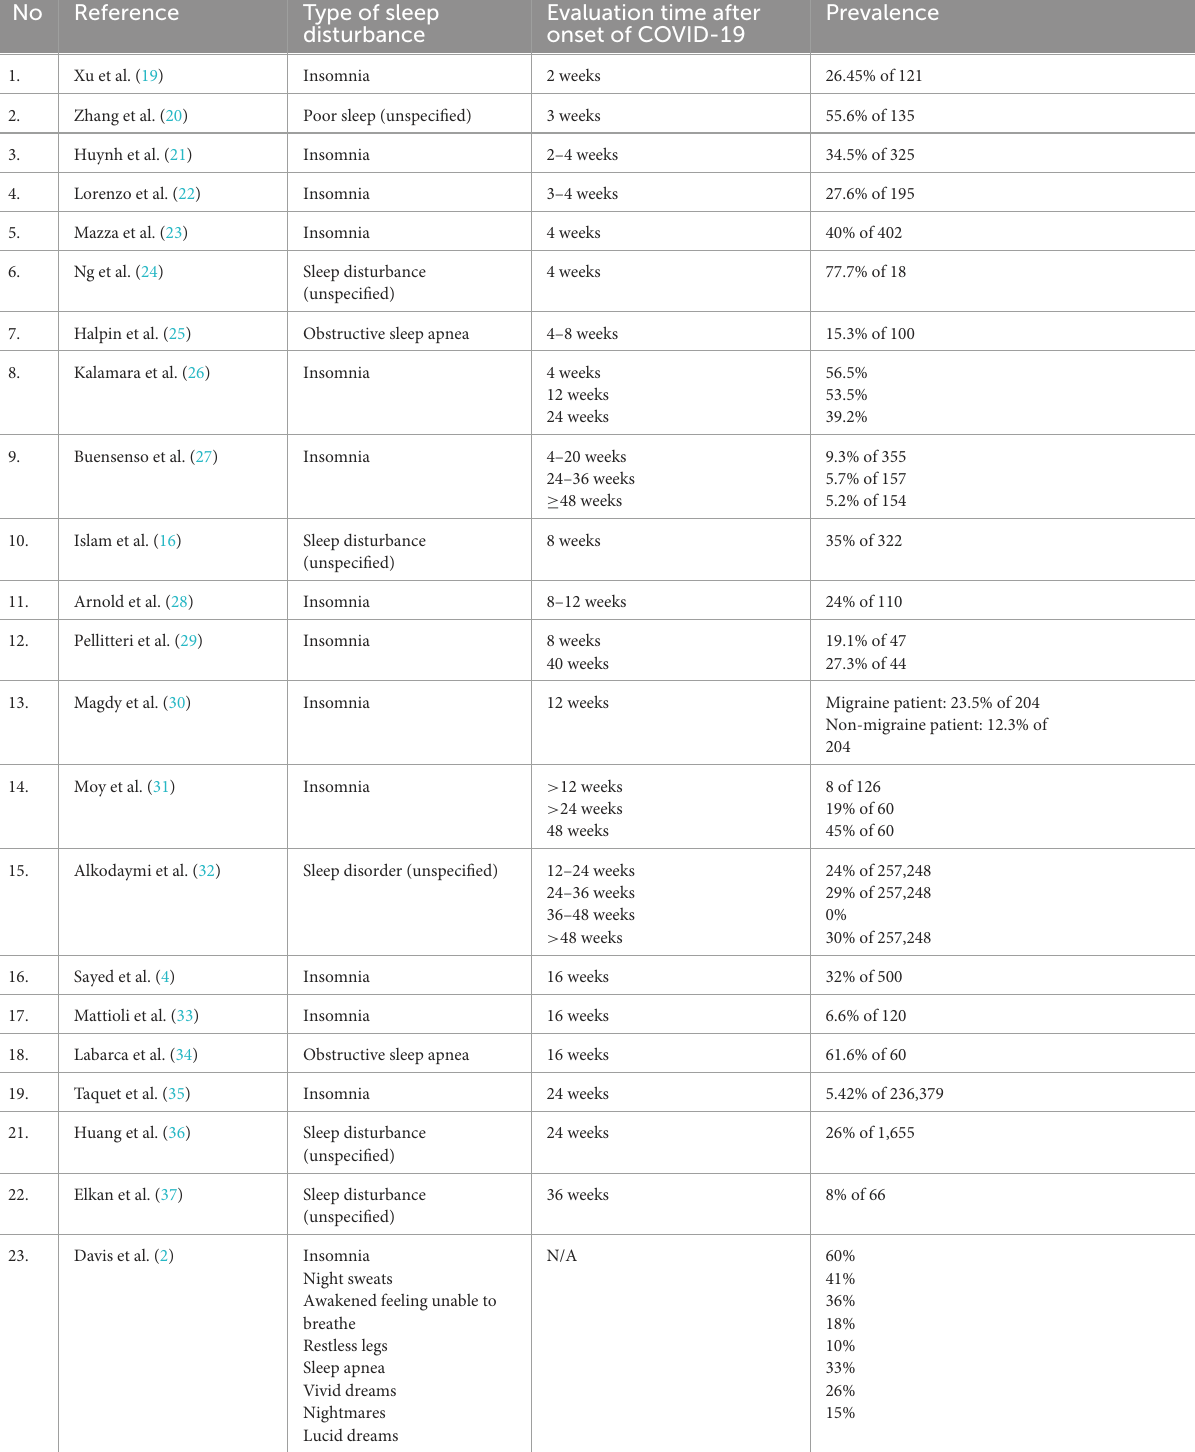
TABLE 1 Type and prevalence of sleep